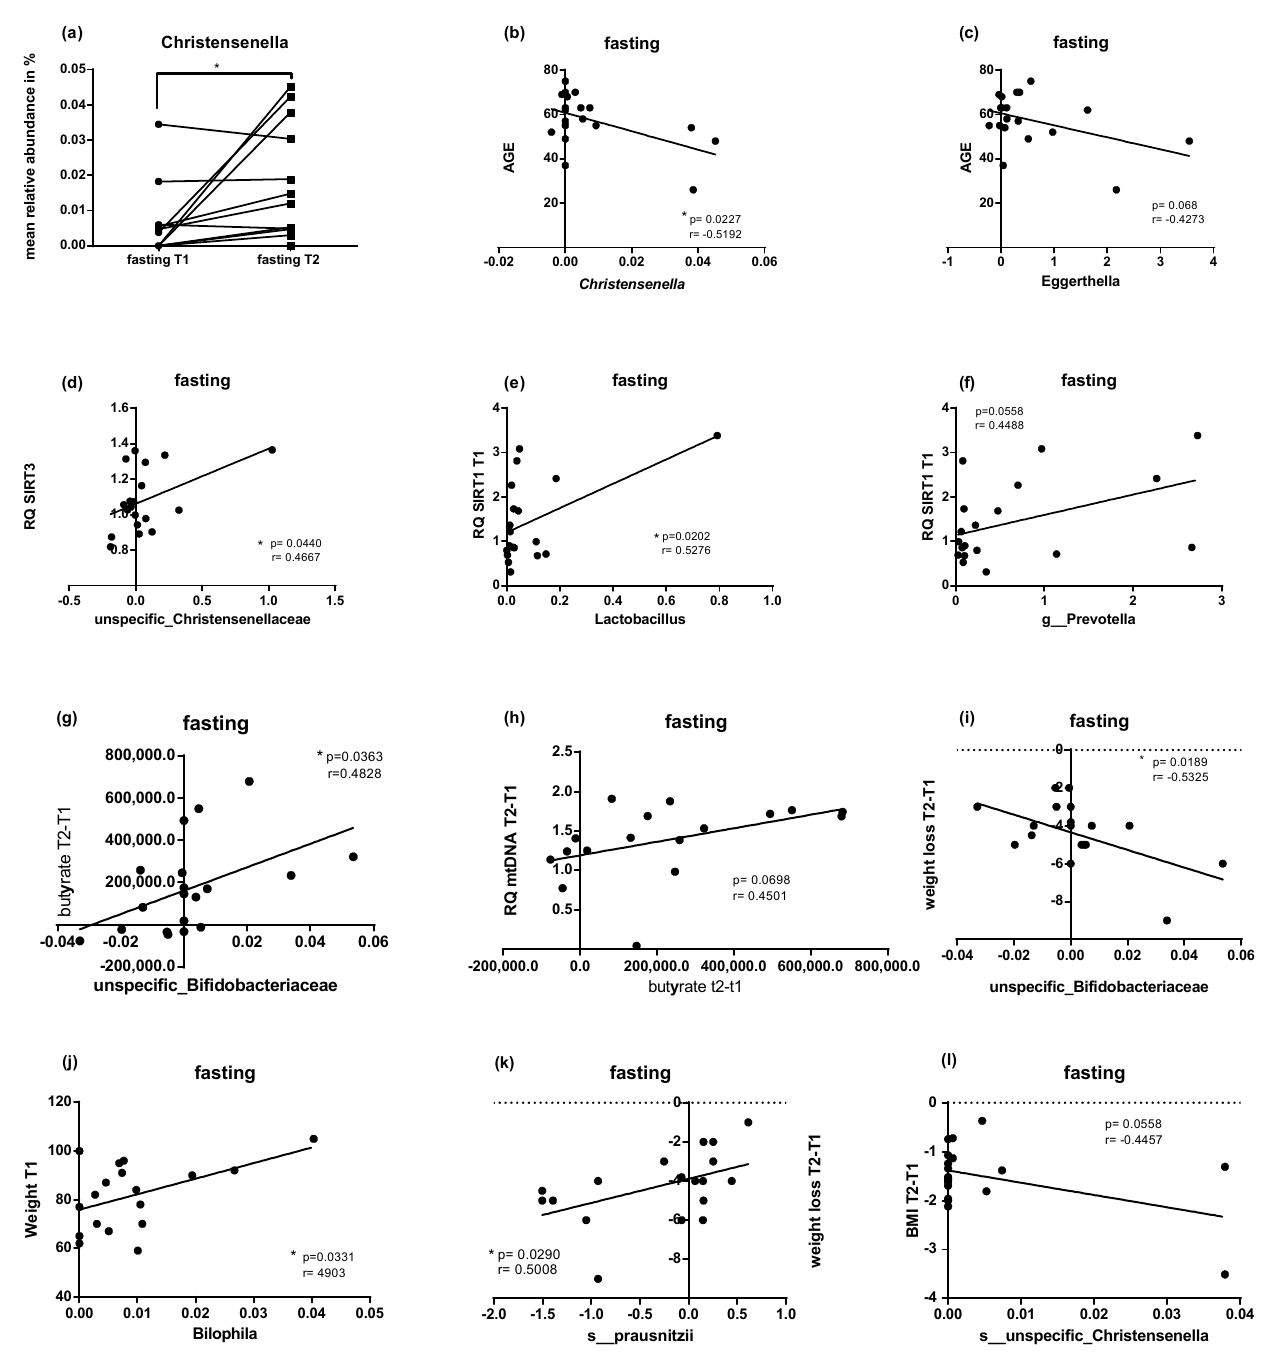
Figure 7. Correlation of gut microbiota at genus level with other biomarkers. Christensenella amount increased after PF described as fasting T1 and fasting T2. Statistical significance was determined using paired t -test for parametric values ( a ) Several Pearson correlations of gut microbiota with age, weight, weight loss, gene expression, butyrate, and BMI at different timepoints are illustrated from ( b – l) . Statistical significance was defined as a p -value below 0.05.